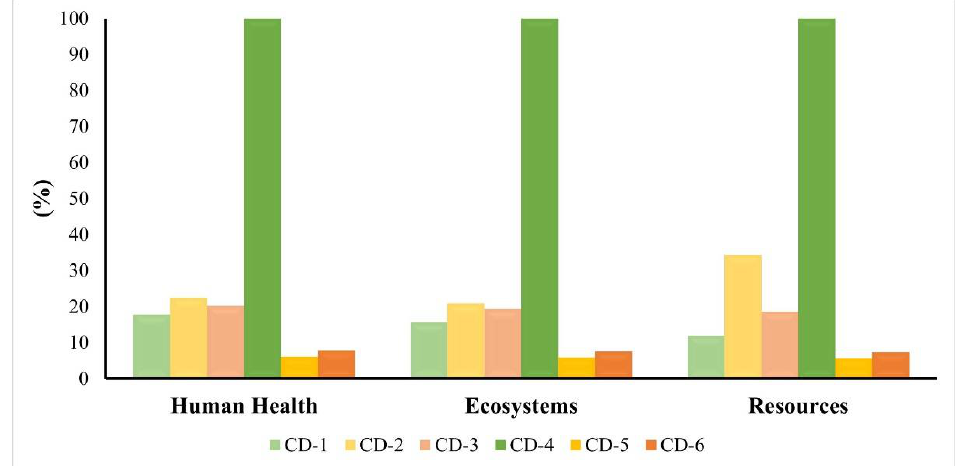
Figure 1. Relative environmental impacts of syntheses under study, applying ReCiPe method. Green scale refers to hydrothermal treatments; Yellow scale refers to microwave-assisted treatments; Orange scale refers to calcination treatments.